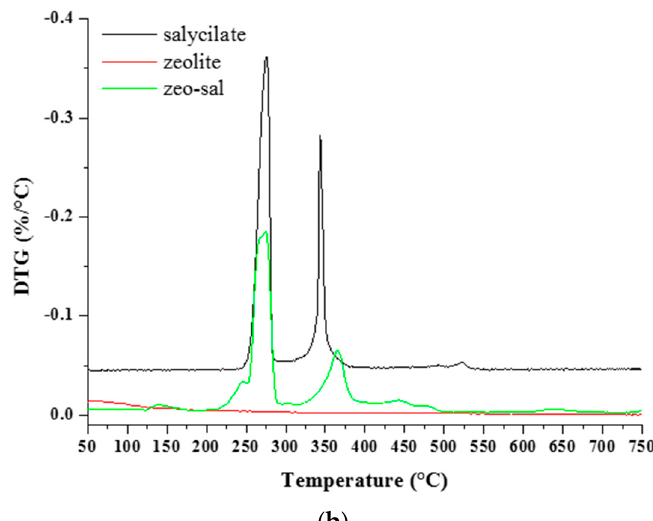
Figure 2. Thermogravimetric analysis on the salicylate, zeolite, and zeolite-salicylate hybrid. ( a ) TGA curves; ( b ) DTG curves.